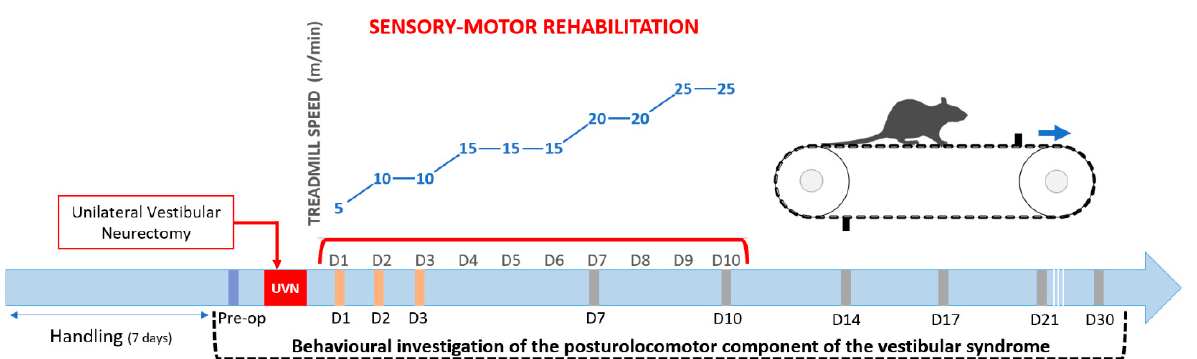
Figure 1. Study design: Details of the procedure used to evaluate quantitatively and qualitatively the vestibular syndrome before and after unilateral vestibular neurectomy . Behavioural investigation of the posturolocomotor component of the vestibular syndrome was made in a first preoperative session (serving as a reference value) and then at 1, 2, 3, 7, 10, 14, 17, 21, and 30 post-lesioned days. The animals in the rehabilitation group were trained from D1 to D10, twice a day on a treadmill task with obstacle clearance. Treadmill speeds were gradually increased as shown in the figure.